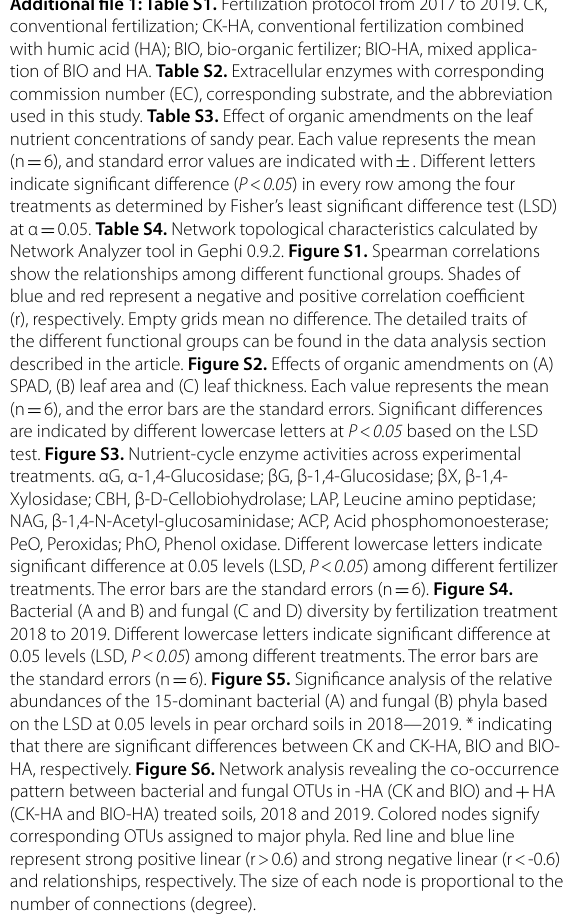
test. Figure S3. Nutrient-cycle enzyme activities across experimental treatments. αG, α-1,4-Glucosidase; βG, β-1,4-Glucosidase; βX, β-1,4- Xylosidase; CBH, β-D-Cellobiohydrolase; LAP, Leucine amino peptidase; NAG, β-1,4-N-Acetyl-glucosaminidase; ACP, Acid phosphomonoesterase; PeO, Peroxidas; PhO, Phenol oxidase. Different lowercase letters indicate significant difference at 0.05 levels (LSD, P < 0.05 ) among different fertilizer treatments. The error bars are the standard errors (n 6). Figure S4. = Bacterial (A and B) and fungal (C and D) diversity by fertilization treatment 2018 to 2019. Different lowercase letters indicate significant difference at 0.05 levels (LSD, P < 0.05 ) among different treatments. The error bars are the standard errors (n 6). Figure S5. Significance analysis of the relative = abundances of the 15-dominant bacterial (A) and fungal (B) phyla based on the LSD at 0.05 levels in pear orchard soils in 2018—2019. * indicating that there are significant differences between CK and CK-HA, BIO and BIO- HA, respectively. Figure S6. Network analysis revealing the co-occurrence pattern between bacterial and fungal OTUs in -HA (CK and BIO) and HA + (CK-HA and BIO-HA) treated soils, 2018 and 2019. Colored nodes signify corresponding OTUs assigned to major phyla. Red line and blue line represent strong positive linear (r > 0.6) and strong negative linear (r < -0.6) and relationships, respectively. The size of each node is proportional to the number of connections